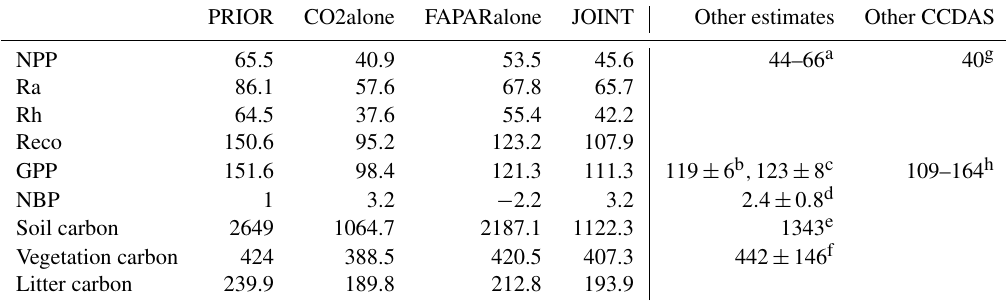
Table 6. Global averages of selected carbon-cycle components for the years 2005 to 2009 in PgCyr − 1 for fluxes and PgC for stocks and comparison with independent estimates. Ra: autotrophic respiration. Rh: heterotrophic respiration. Reco: ecosystem respiration. NBP = GPP − Reco = GPP − Ra − Rh = NPP − Rh. Vegetation carbon includes quickly overturning leaf and fine root carbon, as well as a woody carbon